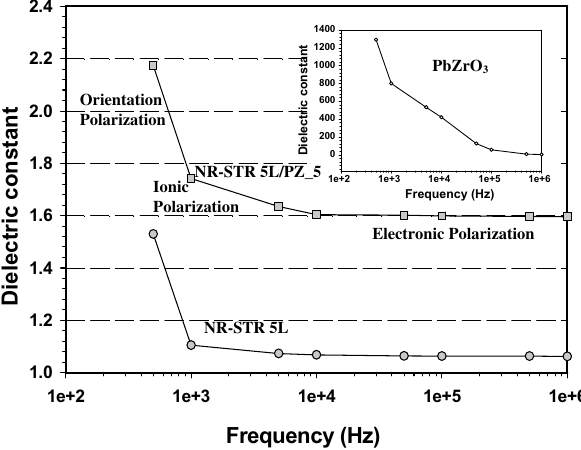
Fig. 4. Dependence of dielectric constant on frequency of NR-STR5L/PbZrO 3 composite materials.